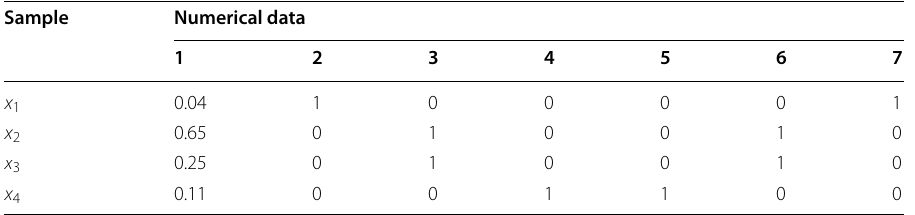
Table 2 The samples according to one-hot encoding method